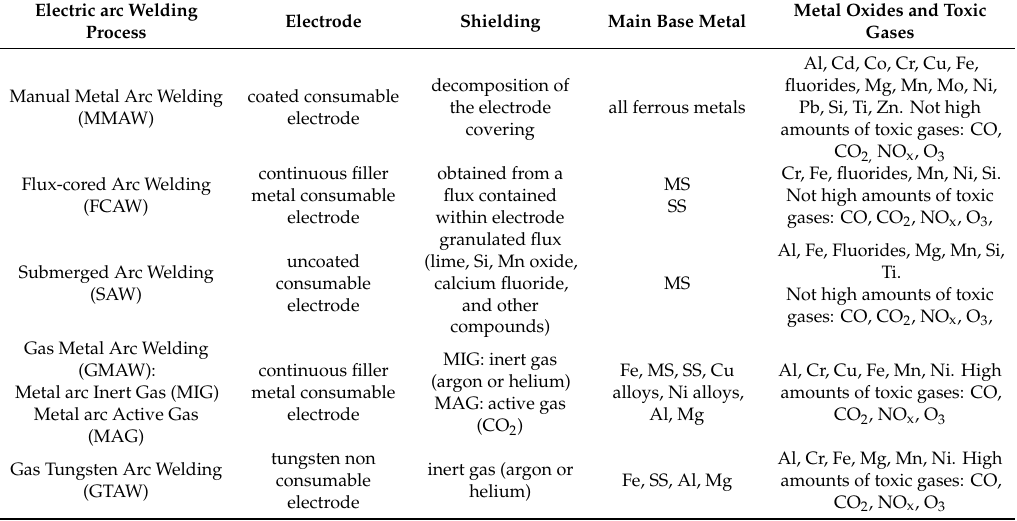
Table 1. Type of electric arc welding